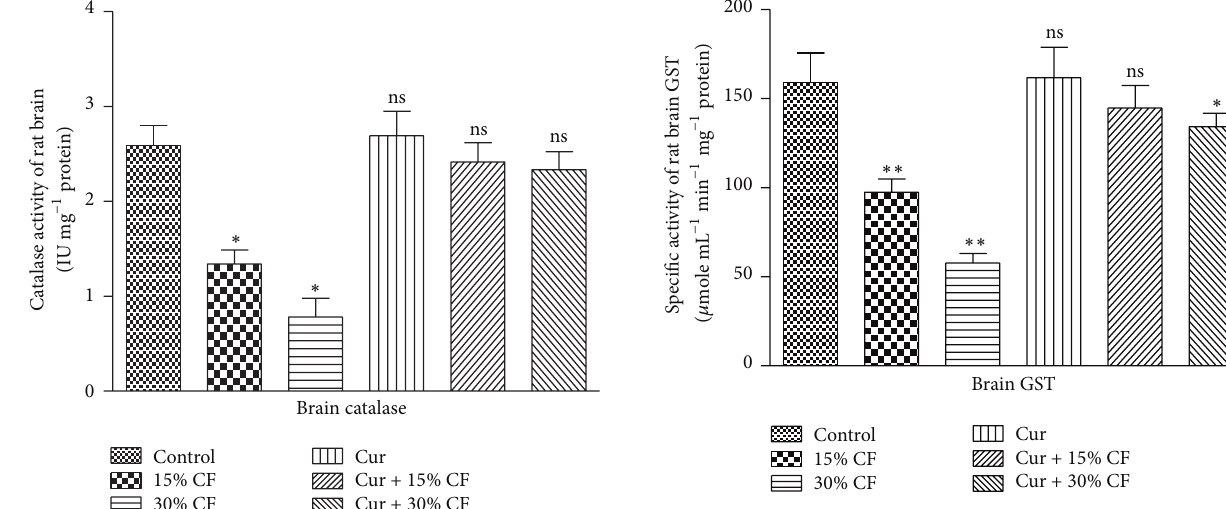
Figure 2: Effects of carbofuran and curcumin on the activity of catalase in the brain stem of rat. The procedures for the adminis- tration of carbofuran and pretreatment with curcumin as well as assay of catalase activity were the same as mentioned in Section 2. The unit of enzyme activity was expressed as IUmg −1 protein. The data represent mean ± SD of 5 independent experiments. ∗ indicates the 𝑃 values significant at < 0.001 and ns refers to nonsignificant at 𝑃 > 0.05 as compared to control group.